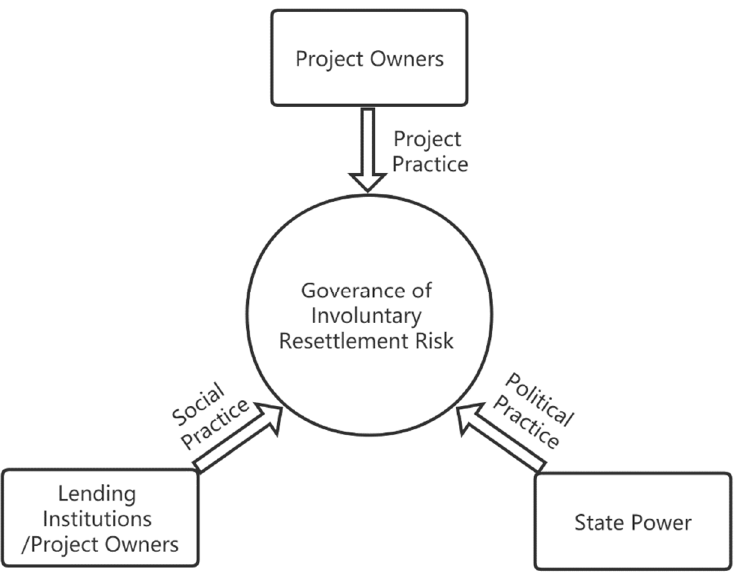
Figure 1. Basic Structure of the Governance of Involuntary Resettlement Risk.